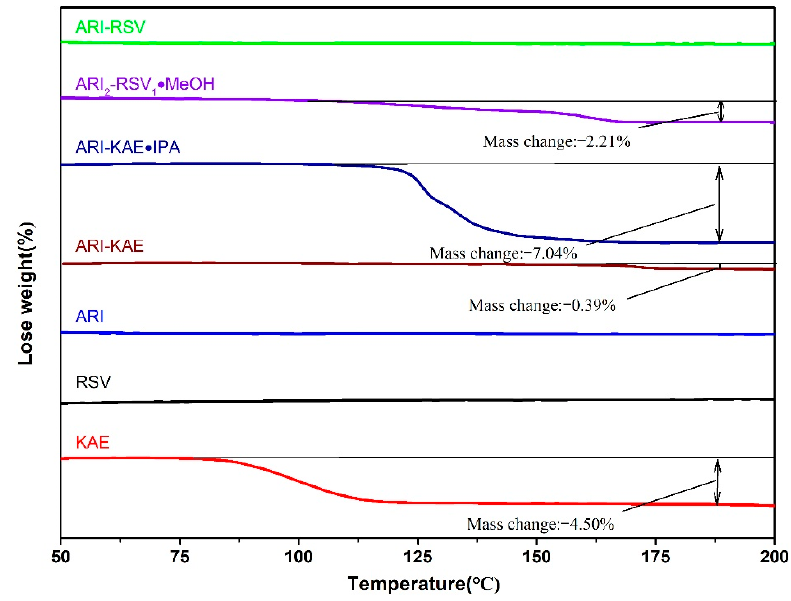
Figure 8. TGA curves of the pharmaceutical cocrystals.